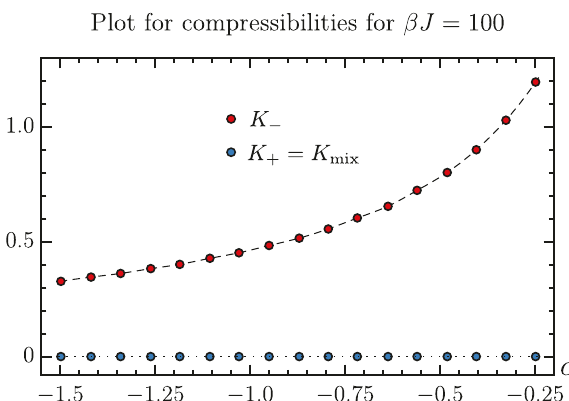
Figure 6 . The numerical results for three different compressibilities as functions of α for J = 1 , β = 100 . We checked that the result does not depend appreciably on β by comparing with the β = 50